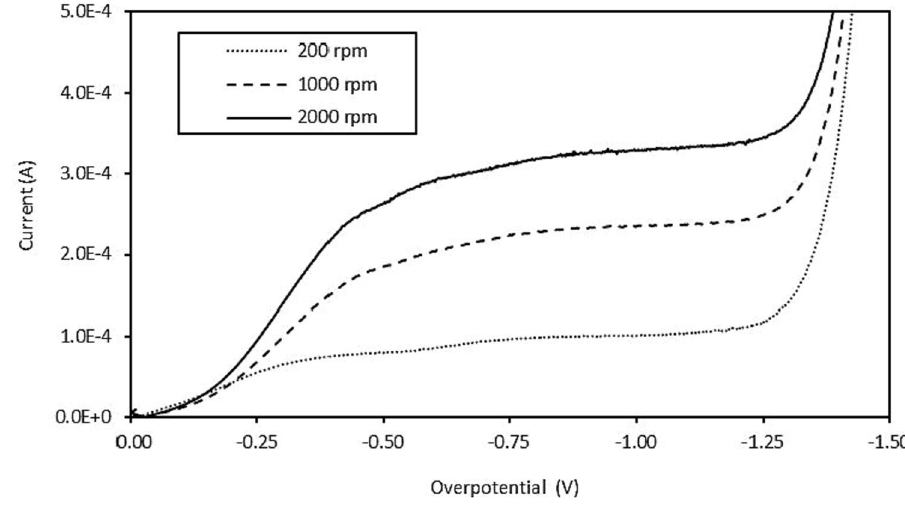
Fig. 12 IV curve for electrode of